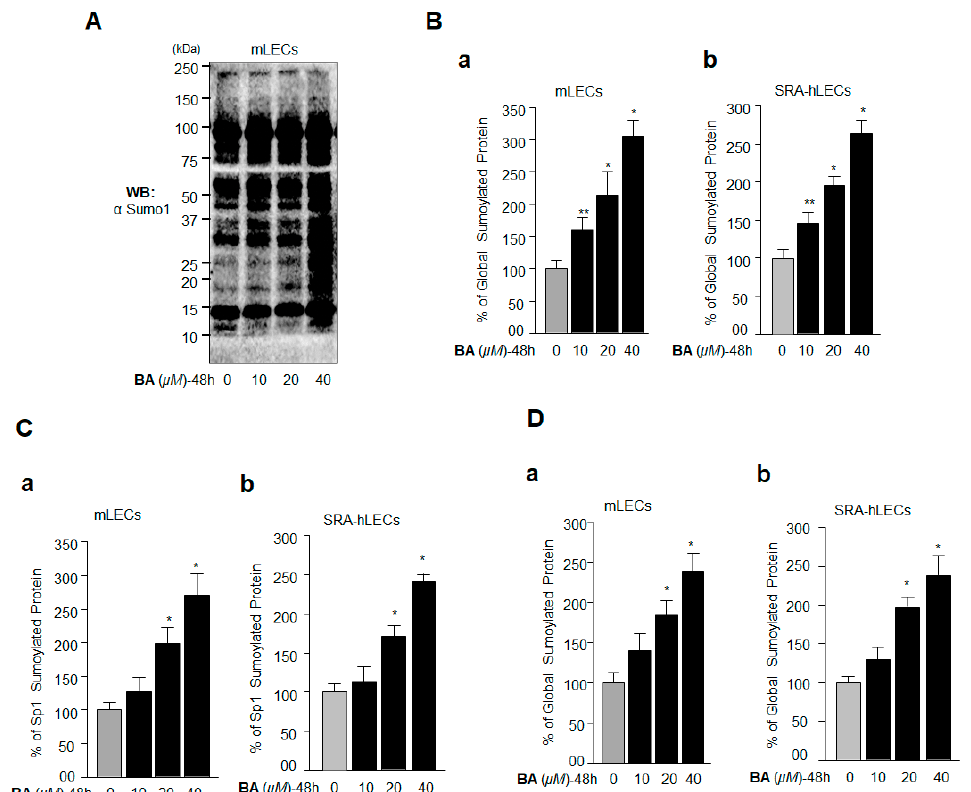
Figure 4. BA amplified global protein Sumoylation including Sp1 and Prdx6 in vivo. ( A ) Aberrant protein Sumoylation by BA in vivo. mLECs were treated with different concentrations of Sumoylation agonist BA for 48 h. Total protein isolated was immunoblotted with anti-Sumo1 antibody and is shown as representative of the result. The protein band of ~15 kDa reflected equal loading of protein samples ( A ). ( B – D ) Sensitive Sumo1 ELISA assay showing BA-induced progressive increase in a global manner, as well as Sp1 and Prdx6 Sumoylation in a dose-dependent manner. Protein was isolated from mLECs and SRA-hLECs treated with different concentrations of BA for 48 h, and an equal amount of protein was loaded onto ELISA plate wells coated with anti-Sumo1 antibody. Global protein Sumoylation was quantified ( B ) (a) (mLECs) and (b) (SRA-hLECs)). Sp1 ( C ) (a) (mLECs) and (b) (SRA-hLECs)) and Prdx6 ( D ) (a) (mLECs) and (b) (SRA-hLECs)) Sumoylation levels were measured using anti-Sp1 and anti-Prdx6 antibodies, respectively. The data represent the mean ± SD from three independent experiments. ** p < 0.05; * p < 0.001.